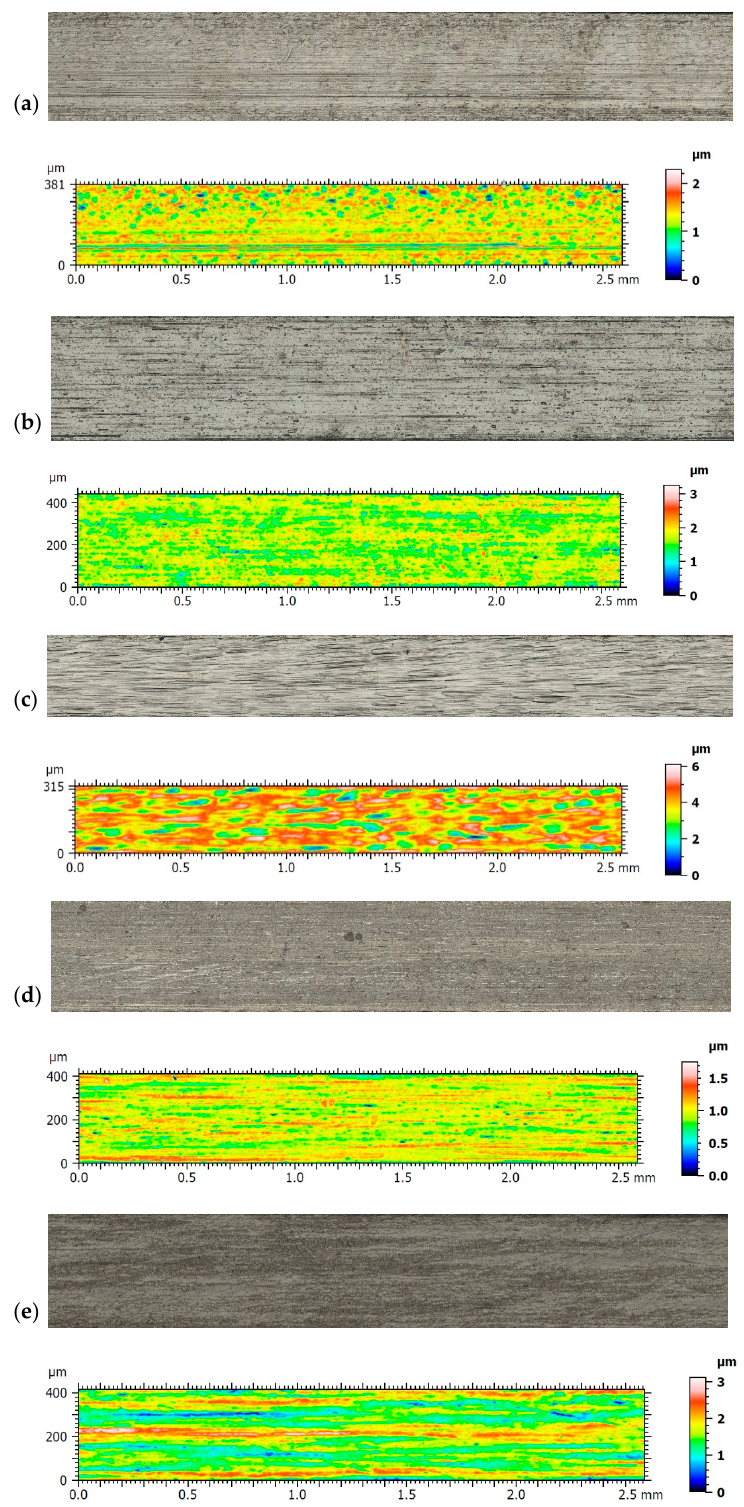
Figure 5. Images of different wires: ( a ) Remanium (SS); ( b ) Nickel-Titanium (NiTi); ( c ) Elgiloy Blue (CoCr); ( d ) BetaForce (TiMo); ( e ) Gummetal (TiNbTaZrO). Results of topography and roughness parameters are presented in Table 7. Table 7. Surface parameters for wires made from different materials.